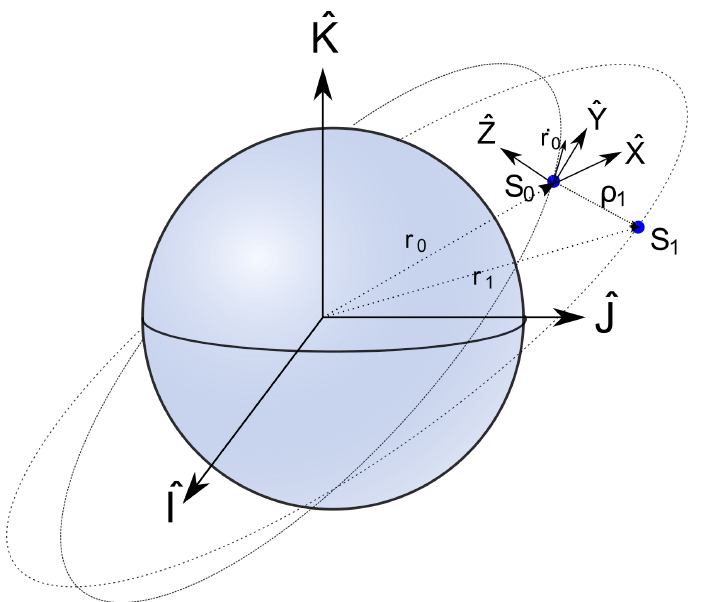
Figure 5. Local-Vertical, Local-Horizontal coordinate